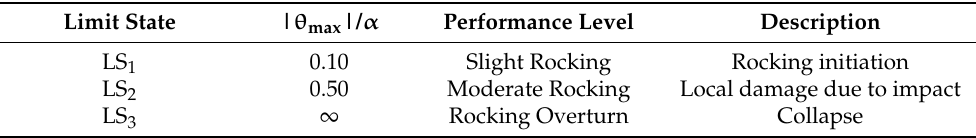
Table 2. Adopted performance levels for rocking